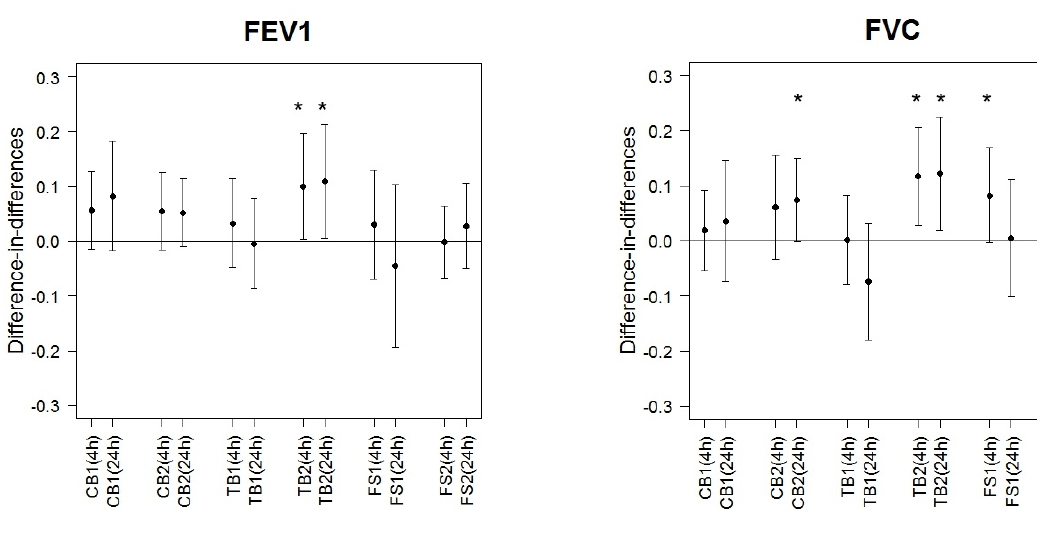
Figure 1. Difference-in-differences of lung function variables (FEV FEV /FVC (%), MEF (L/s)) at 4 h and 24 h after exposure computed for different 1 25%–75% indoor sources and exposure levels contrasting to